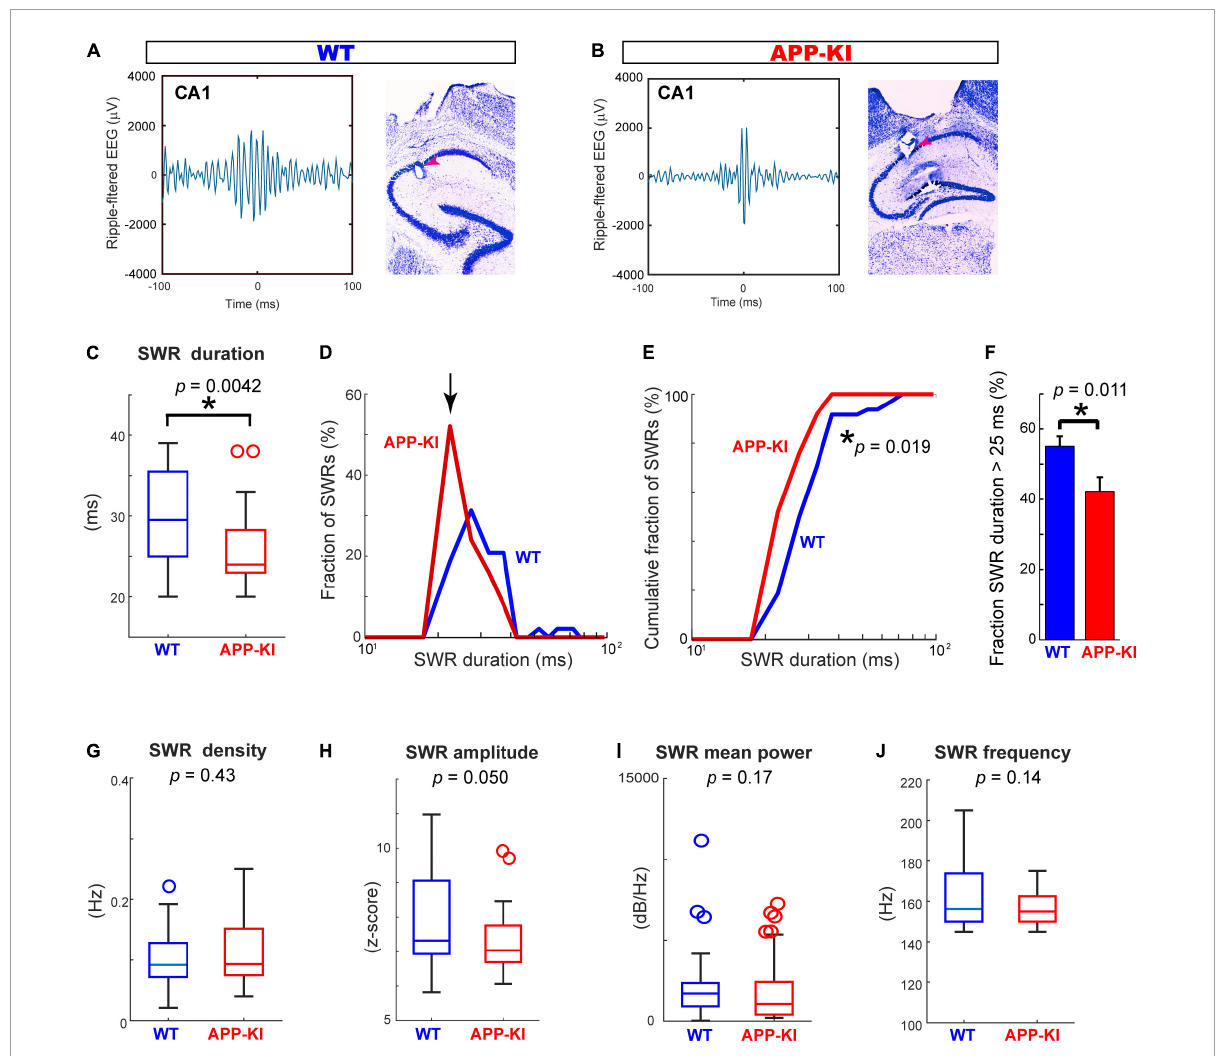
FIGURE3 SWR duration was specifically diminished in CA1 of APP-KI mice. (A,B) Example SWR traces recorded from CA1 in WT (A) and APP-KI mice (B) . (C) SWR duration in CA1. p = 0.0042, Wilcoxon rank-sum test. (D) Fraction of SWRs plotted as a function of SWR duration. APP-KI mice showed larger fraction of SWRs with short duration in CA1 (arrow). (E) Cumulative fraction of CA1 SWRs as a function of SWR duration; p = 0.019, Kolmogorov-Smirnov test. (F) Fraction of CA1 SWRs with duration of > 25 ms; p = 0.011, Wilcoxon rank-sum test. (G–J) SWR properties in CA1. SWR density (G) , SWR amplitude (H) , SWR mean power (I) and SWR Frequency peak (J) . P -values are from Wilcoxon rank-sum test. For all data in (C–J) , n = 48 and n = 25 CA1 recordings in WT and APP-KI mice, respectively. * p <